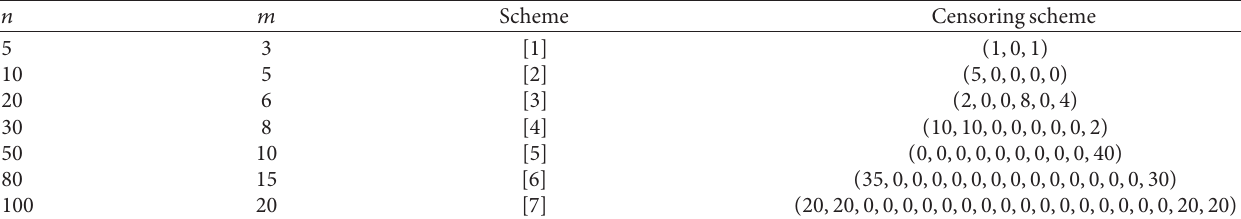
Table 2: Sample sizes and censoring schemes from APE distribution.